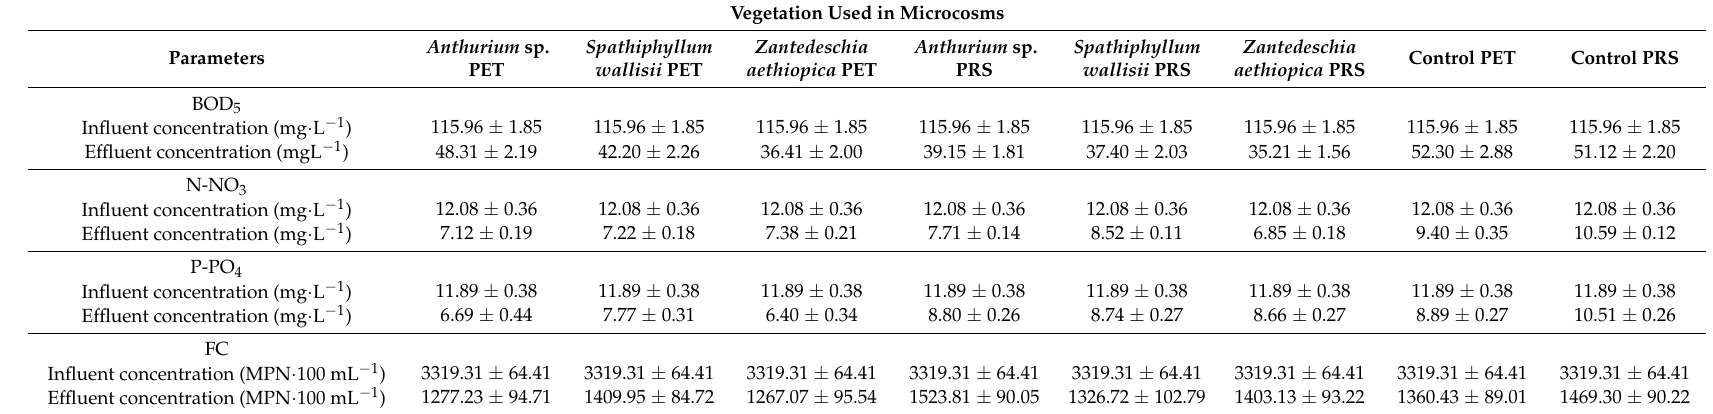
Table 3. Water quality parameters in both the influent and effluent as well as parameter removal in